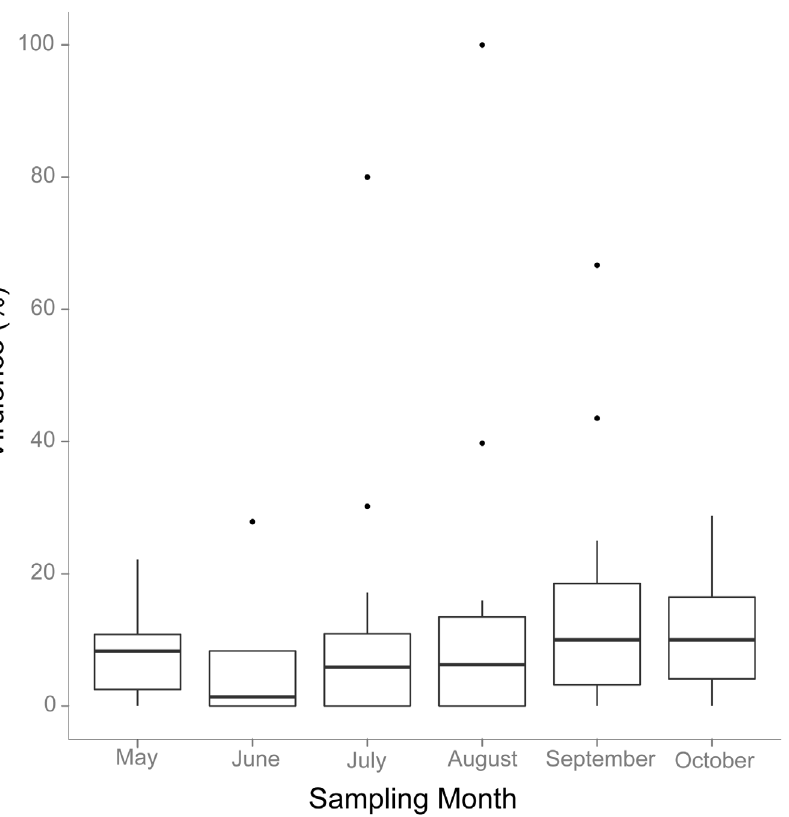
Figure 5. Distribution of induced virulence (%) from May to October 2010. Shown are median virulence values (%) per sampling month, with an interquartile box and a 5 to 95% range. Outliers are marked by black